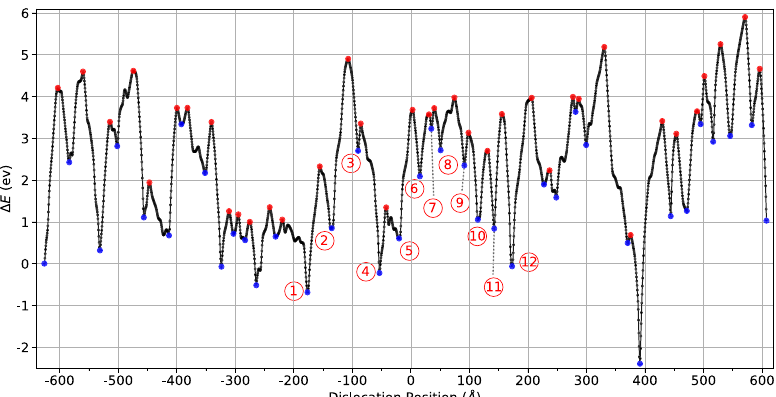
Fig. 2 Energy landscape E ( x ) versus position x for a dislocation moving through one entire simulation cell for NbTaV. Minima and maxima are labeled blue and red, respectively. Numbered labels correspond to dislocation con fi gurations shown in Fig. 3. Few of the labeled paths are shown in Fig. 4 in more detail.